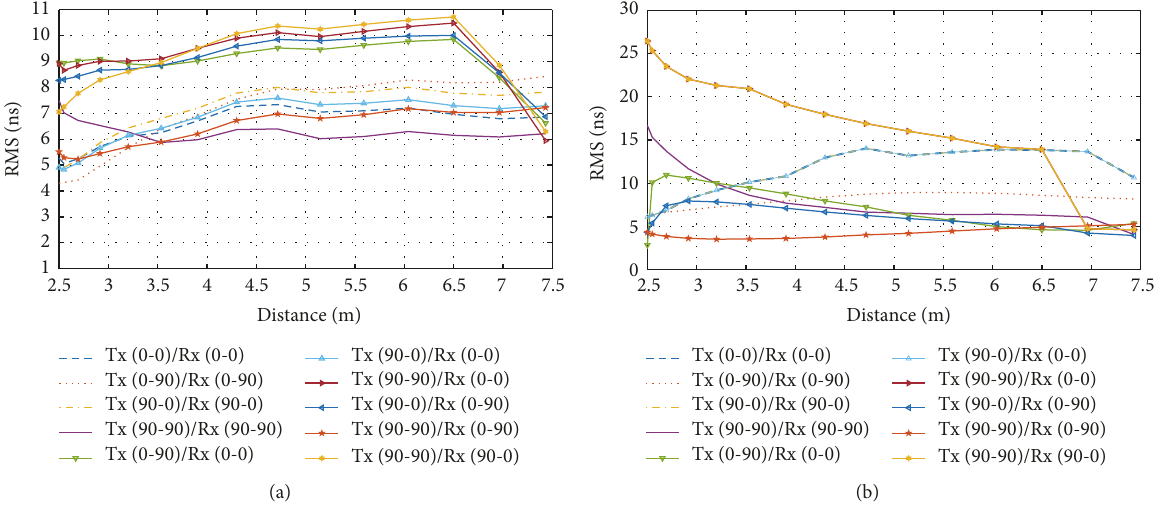
Figure 13: RMS delay spread for the two antennas in the NLOS scenario: (a) 3D cubic antenna and (b) dipole antenna.